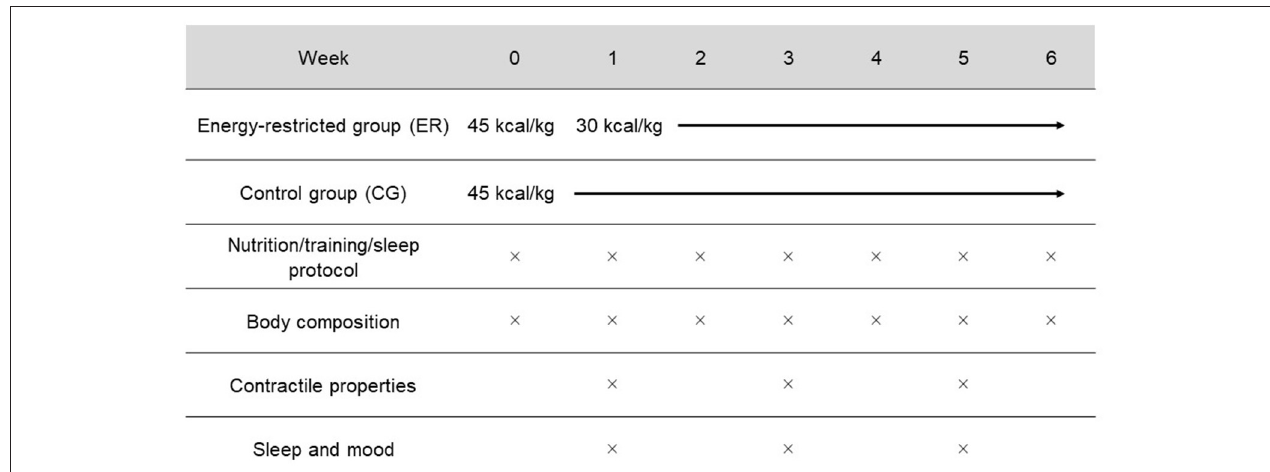
FIGURE 1 | Schematic overview of the study design. In week 0, all participants consumed 100% of their energy requirements (45 kcal/kg). For weeks 1–6, the ER group decreased their energy intake to 30 kcal/kg. Both groups consumed 2.8 g/kg FFM of protein and continued their habitual exercise during the study. As indicated by the × symbol, body composition was assessed weekly. Contractile properties, sleep, and mood were examined at weeks 1, 3, and